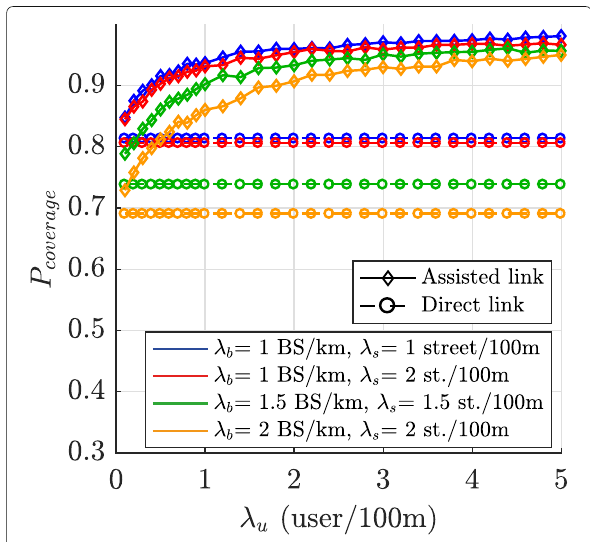
Fig. 10 Coverage probability. Direct link and relay-assisted link for different parameter sets over the user density with a SINR threshold of T = 0dB